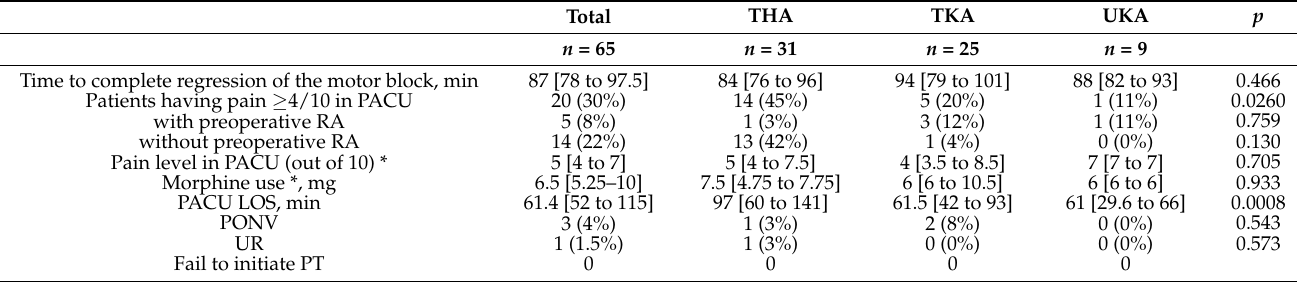
Table 3. Postoperative secondary outcomes.